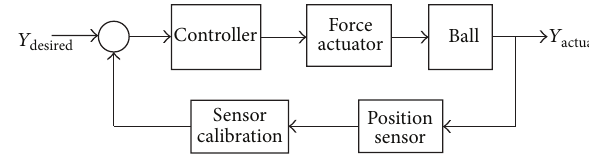
Figure 5: Magnetic levitation system block diagram.